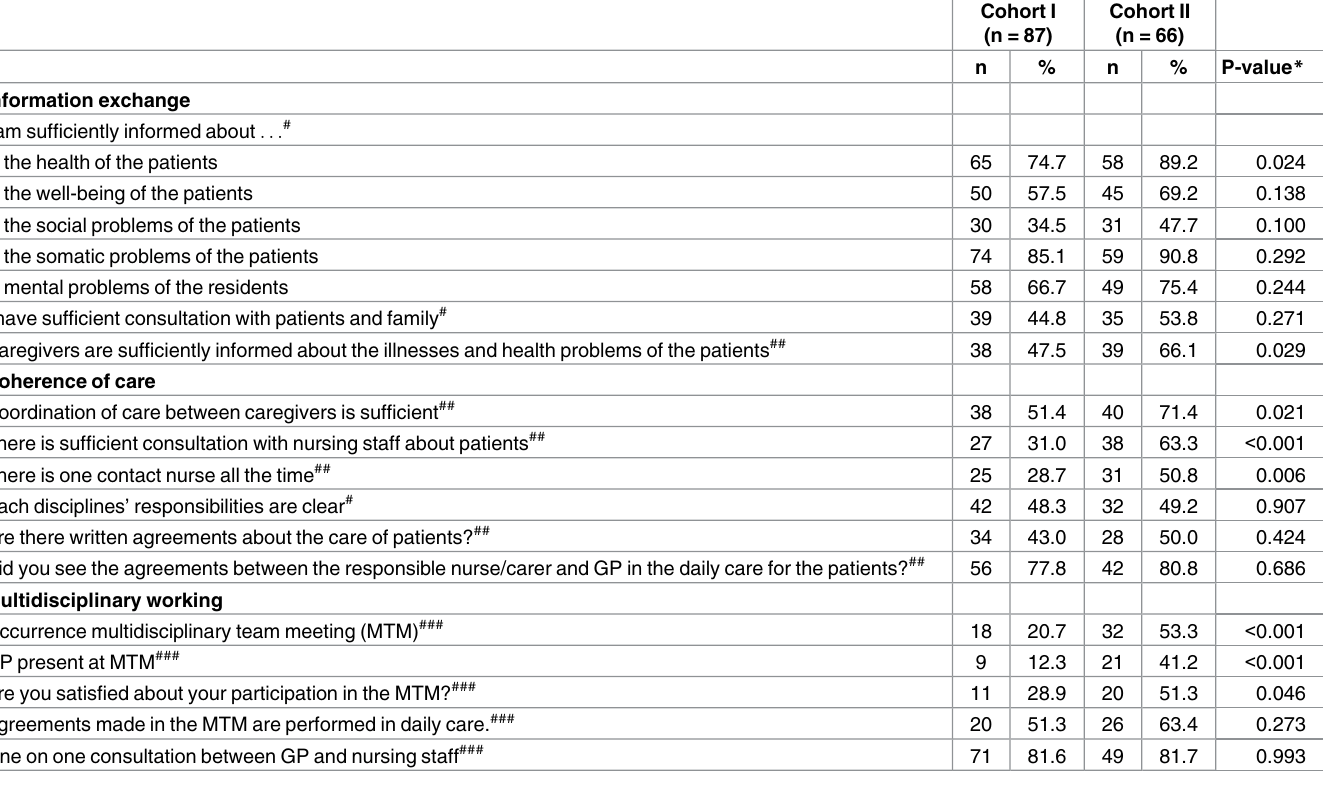
Table 4. Satisfaction about specific aspects of integrated care of GP care in General